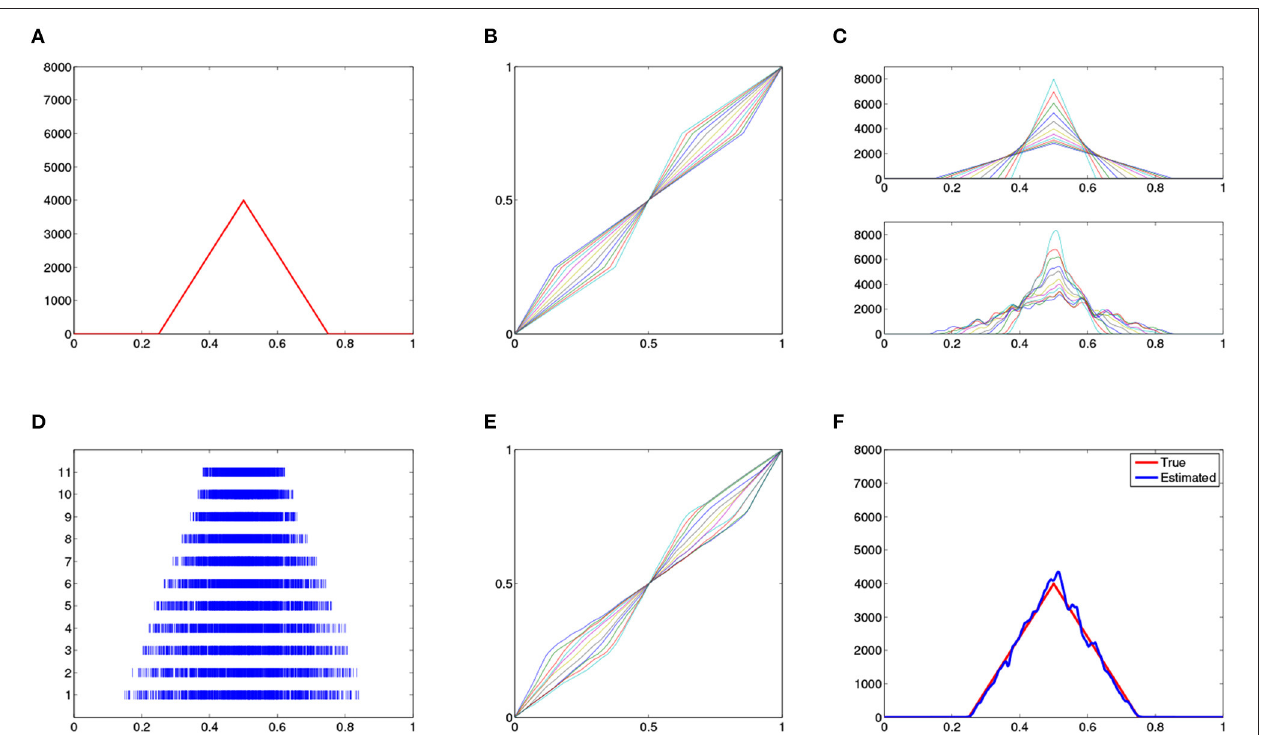
FIGURE 5 | Non-negative intensity estimation. (A) True intensity function. (B) 11 warping functions. (C) (top panel) True warped intensity functions and (bottom panel) estimated intensities with modified kernel method. (D) 11 simulated processes with respect to the warped intensities. (E) Estimated warping functions. (F) Estimated (blue) and true (red) intensity